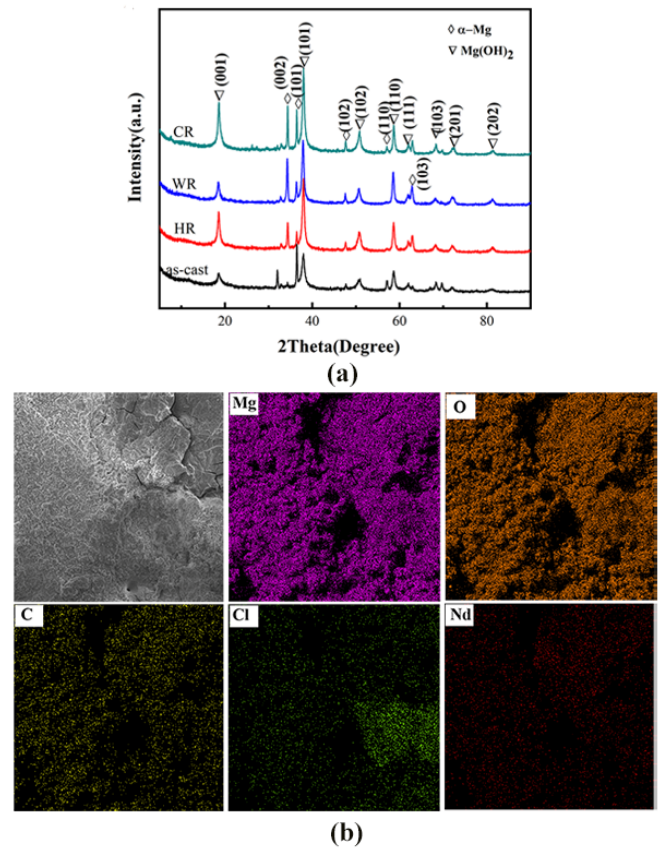
Figure 9. XRD pattern: ( a ) energy spectrum analysis ( b ) and energy spectrum map of the surface corrosion products on WE43 alloy after immersion for 7 days in Hanks’ solution.